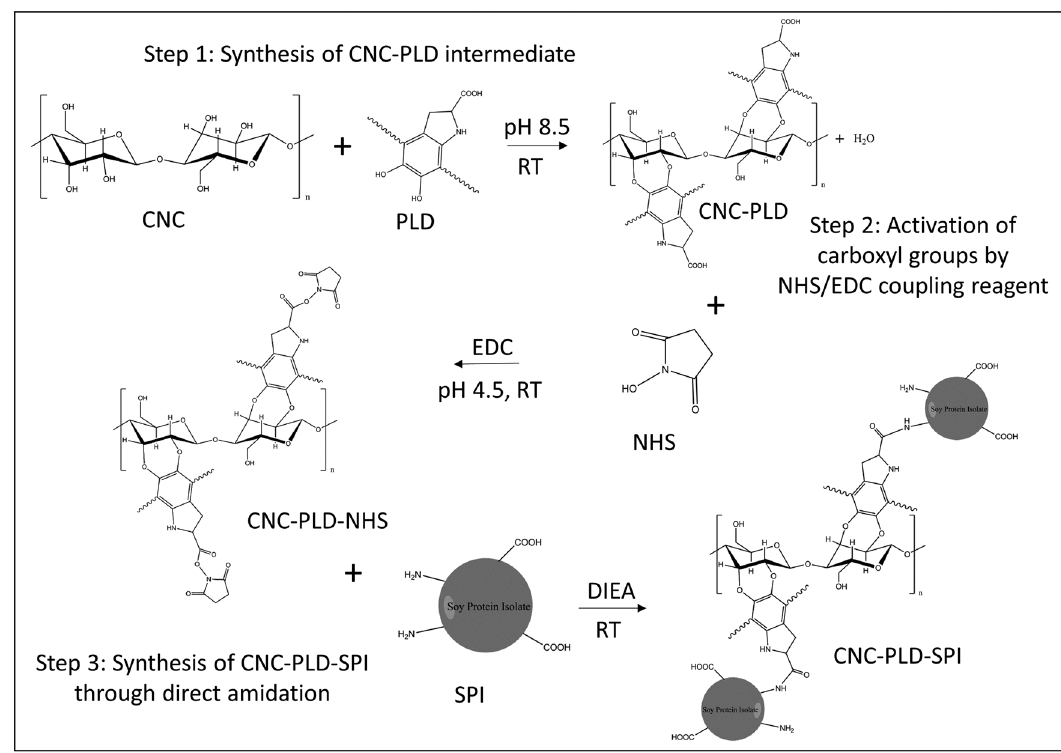
Figure 1: Synthetic routes of CNC – SPI nanoconjugates using poly ( L - dopa ) as a linker and NHS/EDC as the coupling